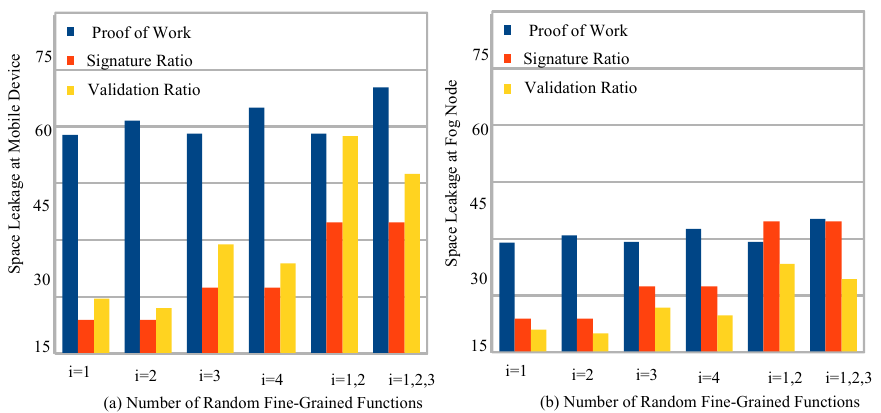
Figure 6. Resource Leakage Issue in Blockchain Technologies While Performing Cryptograhic Schemes for Healthcare Applications